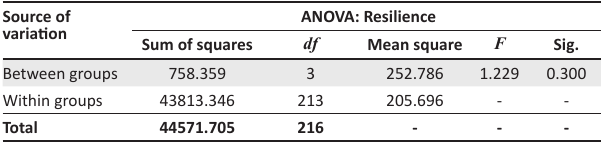
TABLE 5: Analysis of variance resilience across different schools. Source of variation